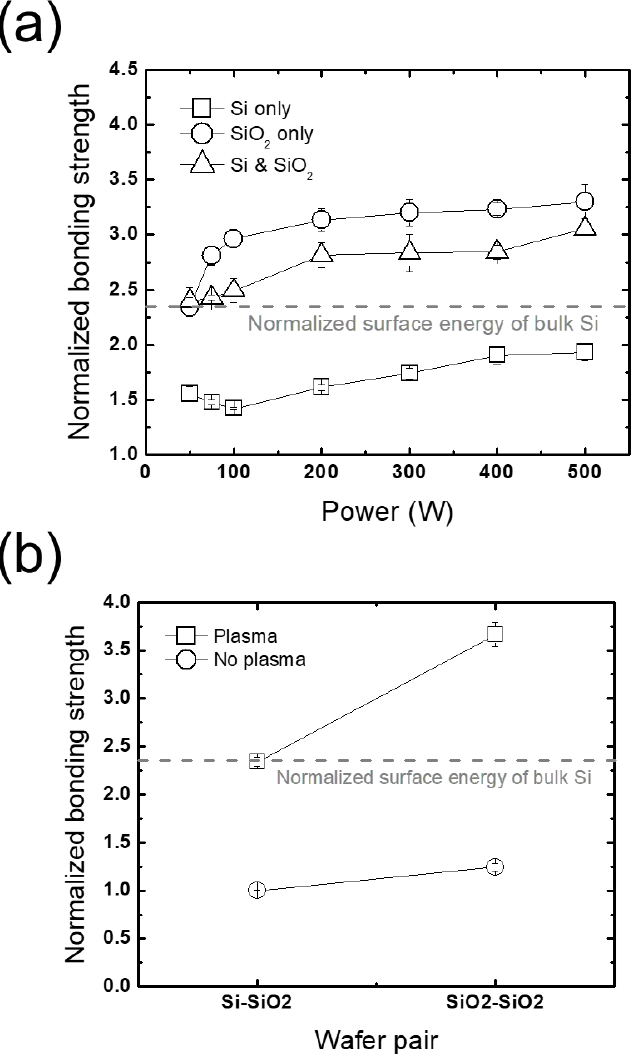
Figure 9. ( a ) Bonding strengths obtained from different plasma surface treatment approaches of Si only, SiO 2 only, and Si & SiO 2 , and ( b ) comparison between bonding strengths of Si-SiO 2 and SiO 2 -SiO 2 pairs with and without plasma treatment normalized to the bonding strength with no plasma